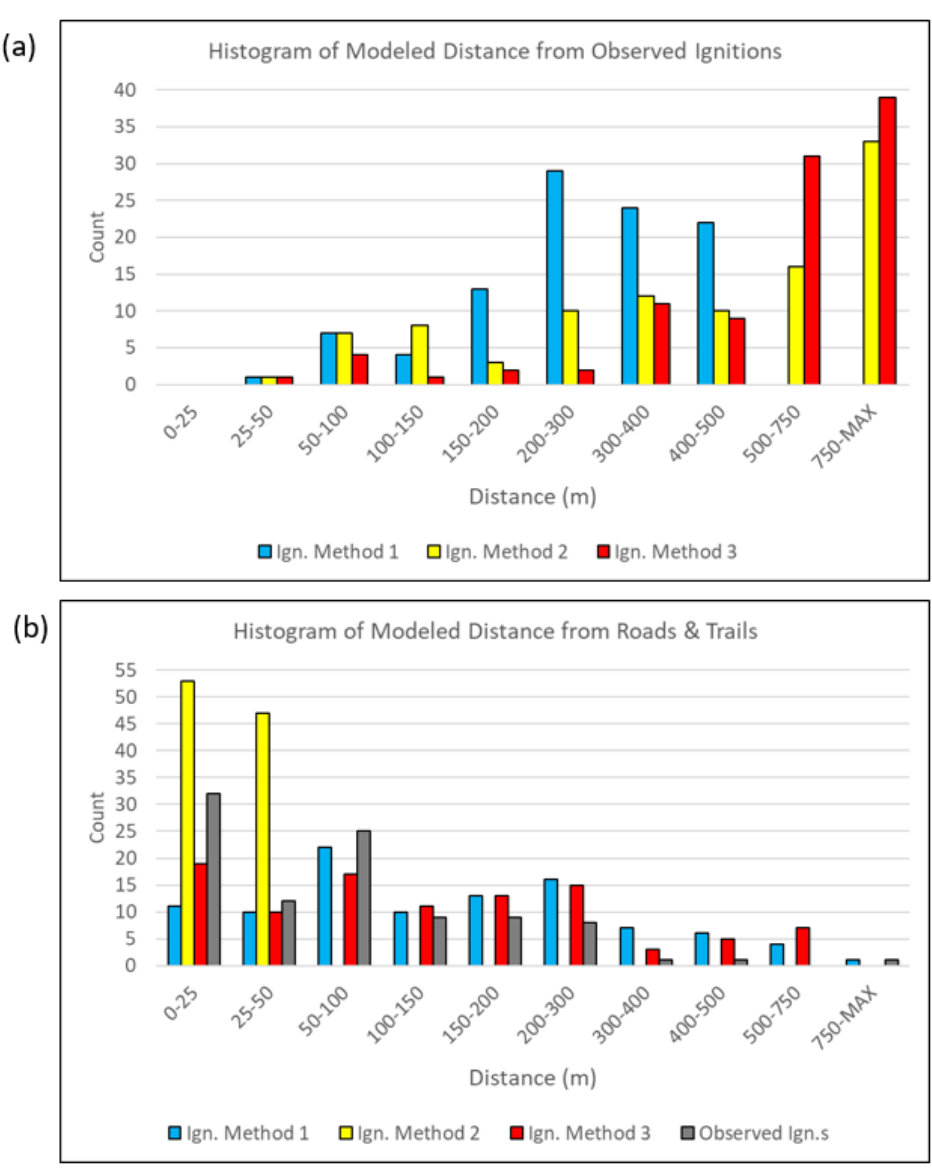
Figure 4. Bar plots showing the distance of each modeled ignition to the nearest observed ignition ( a ) and road or trail ( b ). The observed ignition distance to the nearest road or trail is included in ( b ). The total count for each method is 100.